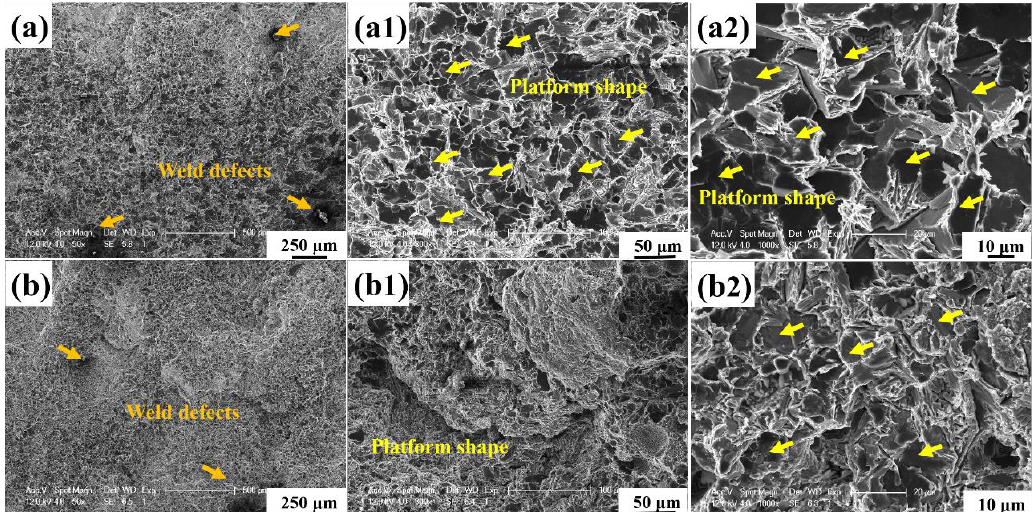
Figure 8. SEM characteristic images of fracture morphology of two groups of joints. ( a – a2 ) Repre- sentative sample Y1; ( b – b2 ) Representative sample